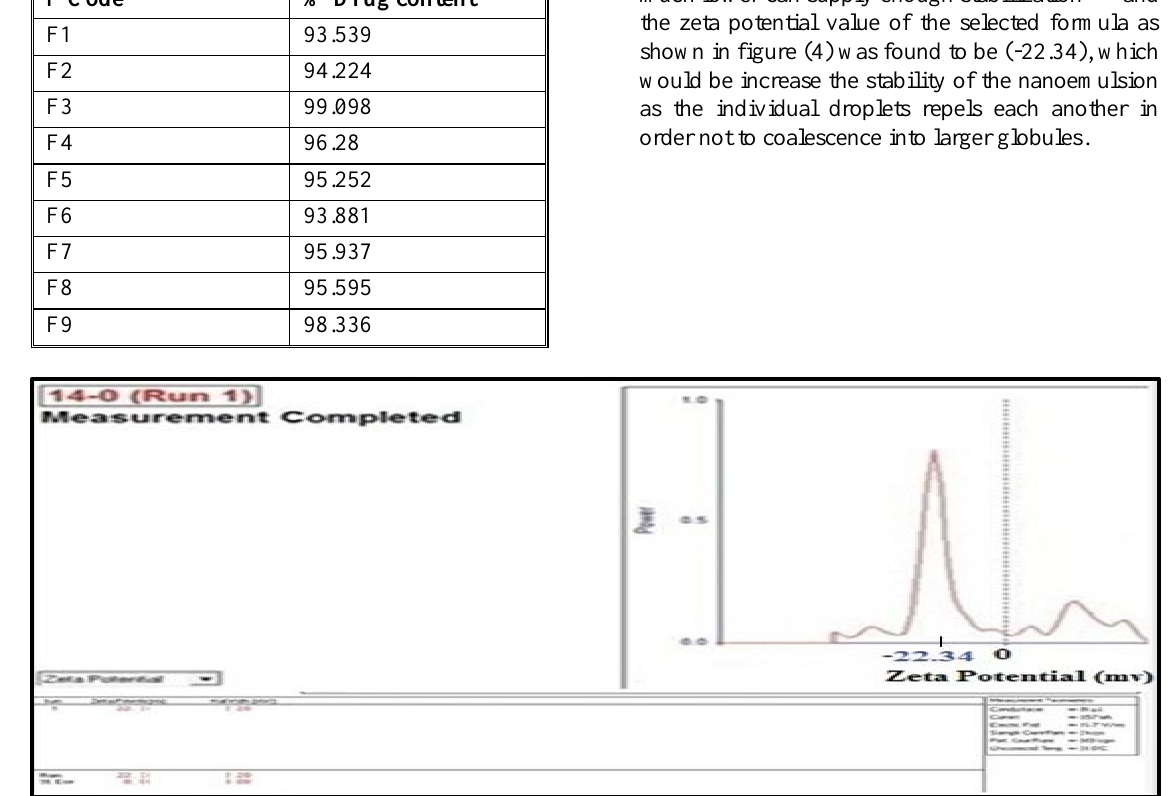
Figure 4. Zeta potential of formula (F3) Viscosity measurements